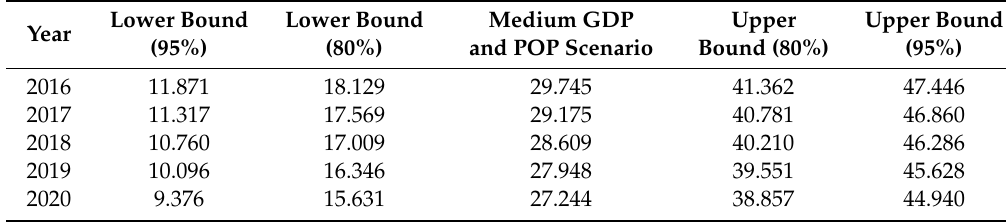
Table 5. Forecast intervals (unit: 10 6 ha).